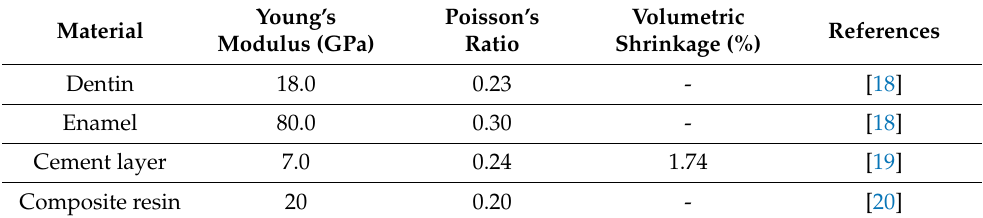
Table 1. Mechanical properties of materials: Young’s modulus, Poisson’s ratio, and linear